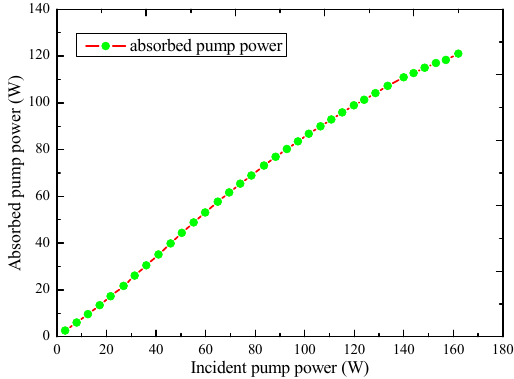
Figure 2. The Nd:YAG SCF’s absorption for 808 nm pump laser.